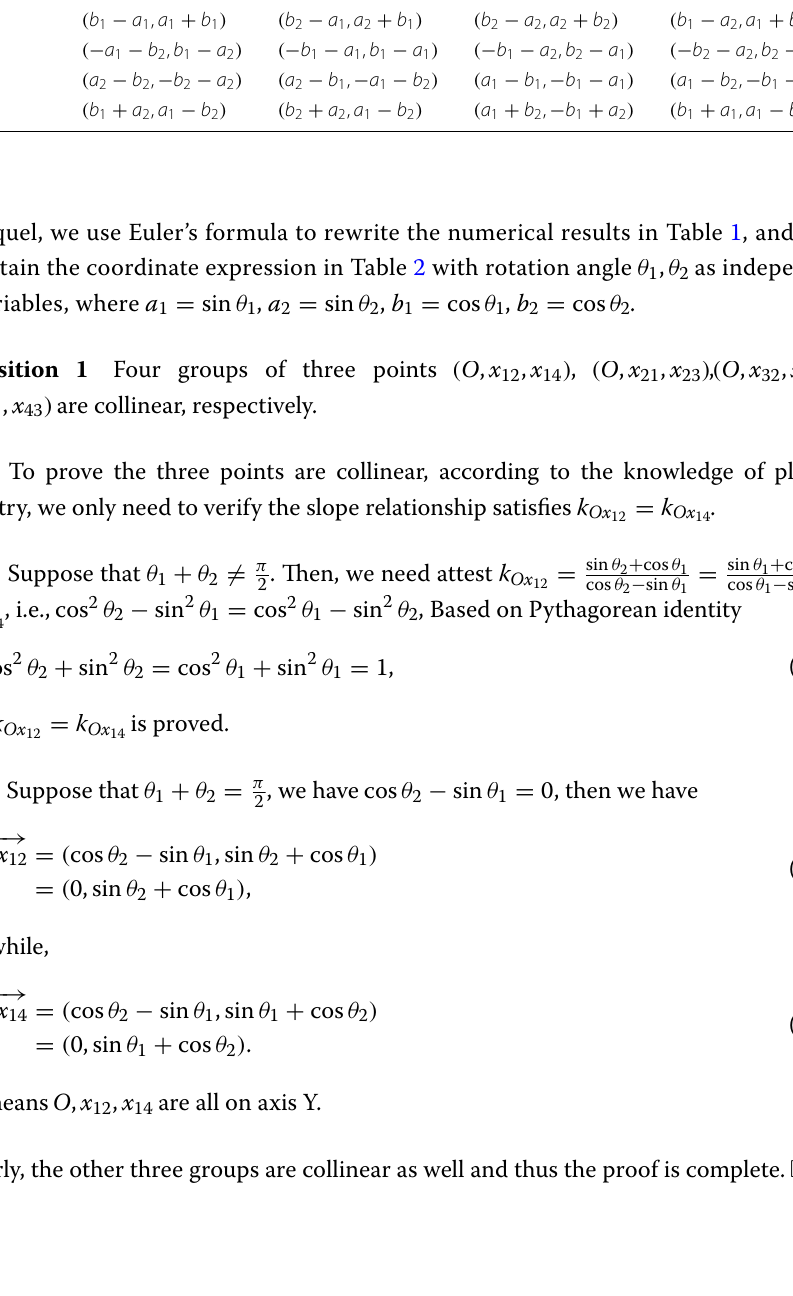
Table 2 Coordinate expression with θ 1 , θ 2 Constellation x